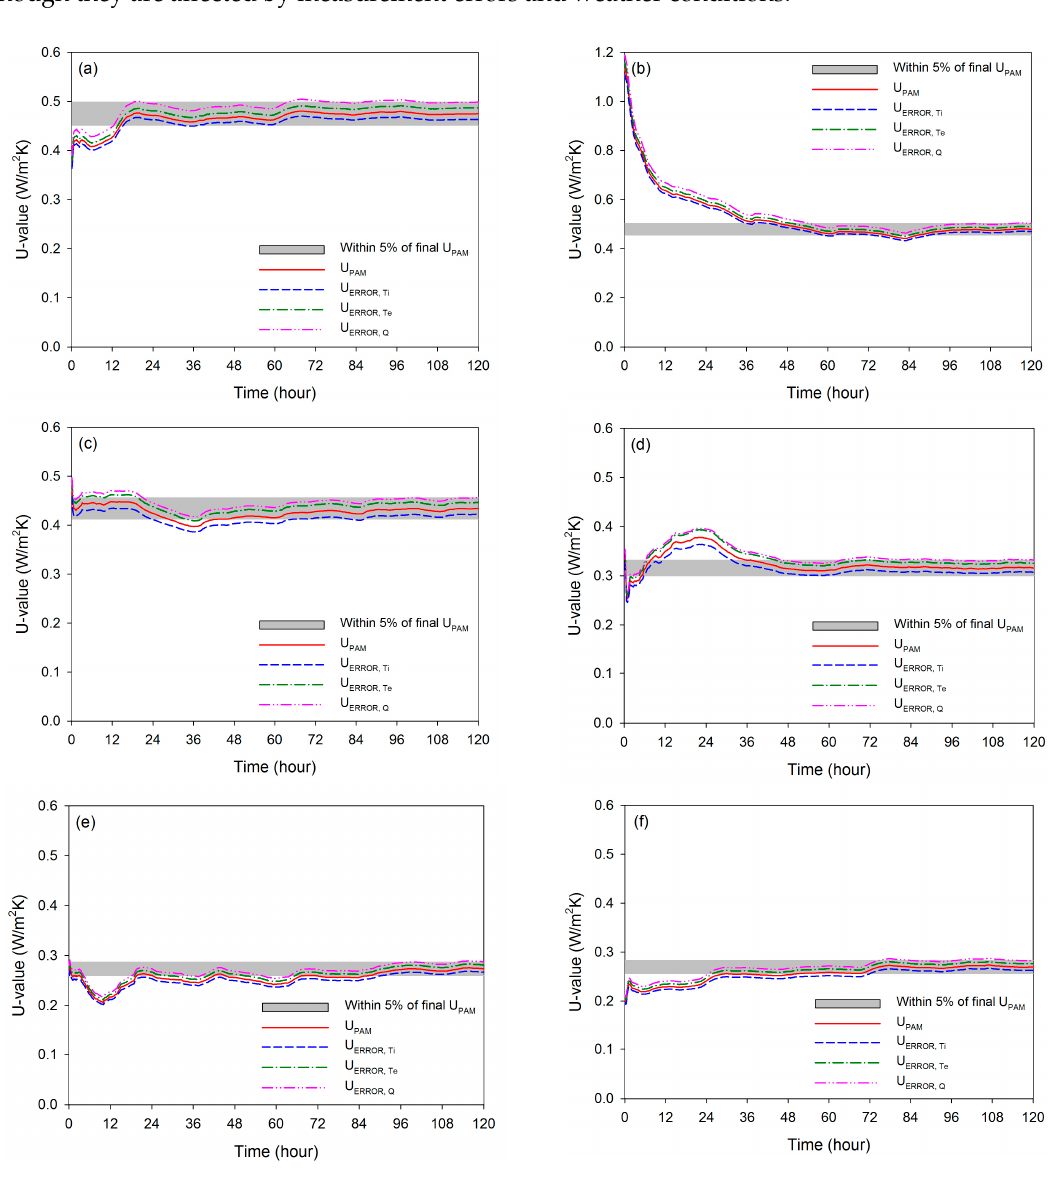
Figure 4. Evolution of in situ U -values analyzed by progressive average method and by progressive average method with application of measurement uncertainty: ( a ) Case 1; ( b ) Case 2; ( c ) Case 3; ( d ) Case 4; ( e ) Case 5; ( f ) Case 6.